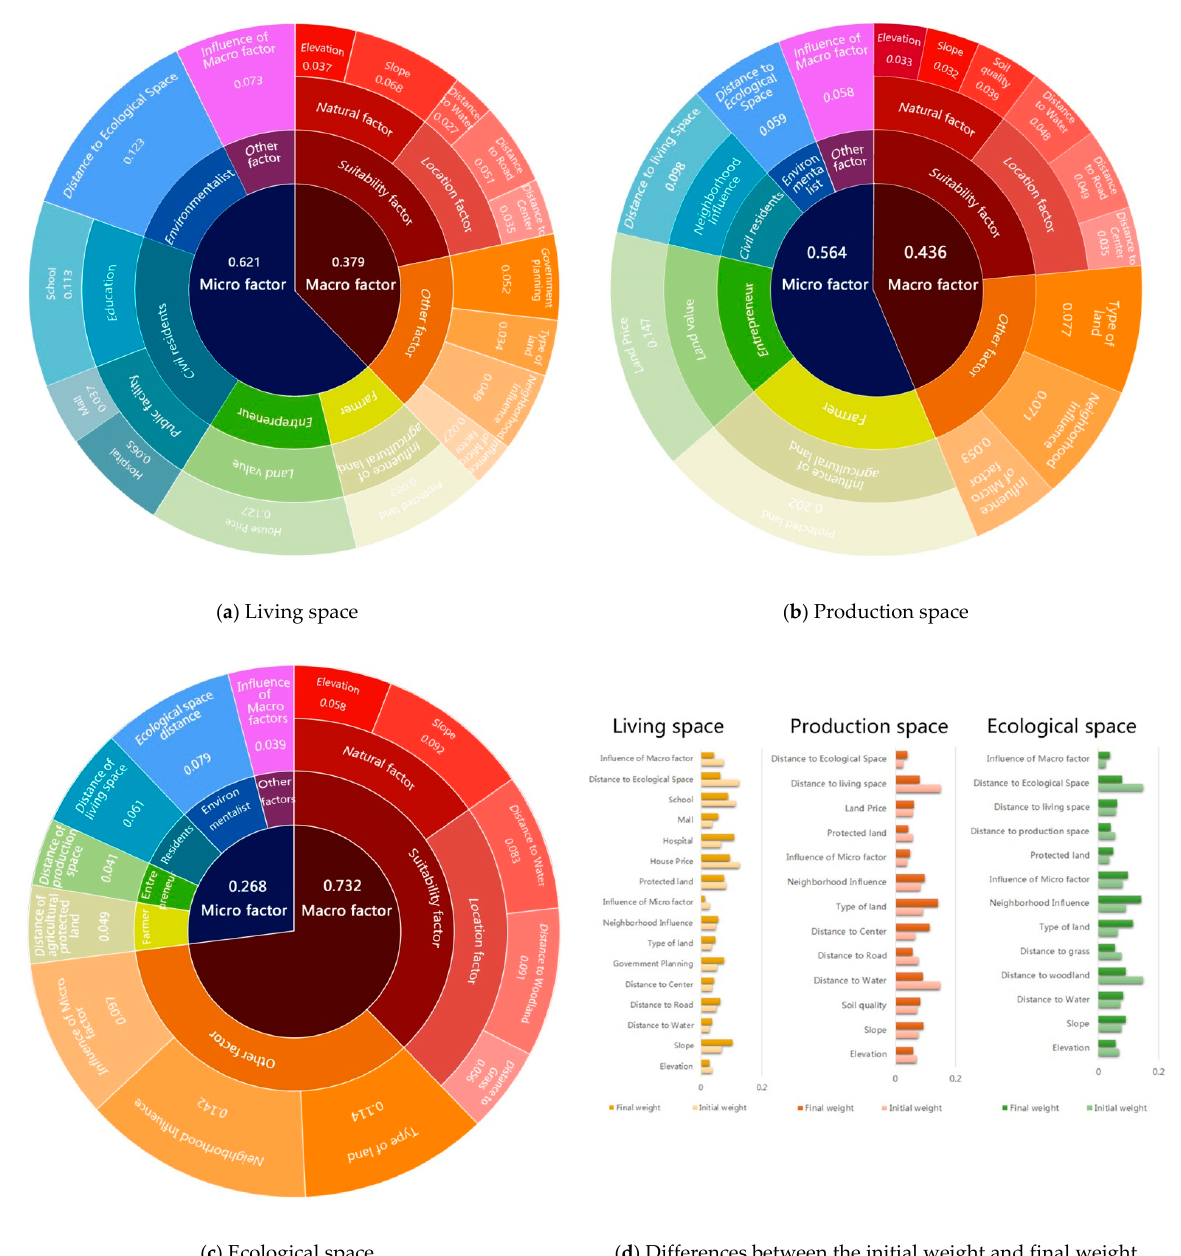
Figure 7. Final weight determination results of living space ( a ), production space ( b ) and ecological space ( c ) evolution simulation factors and their differences with the initial weights ( d ).